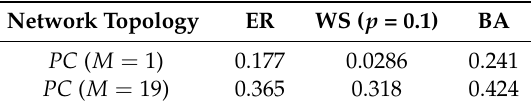
Table 2. The proportion of cooperation in the selected strategies ( PC ) when M = 1 and M = 19 in different types of networks. The multiplex networks contribute to the promotion of cooperation allowing for the difference in network